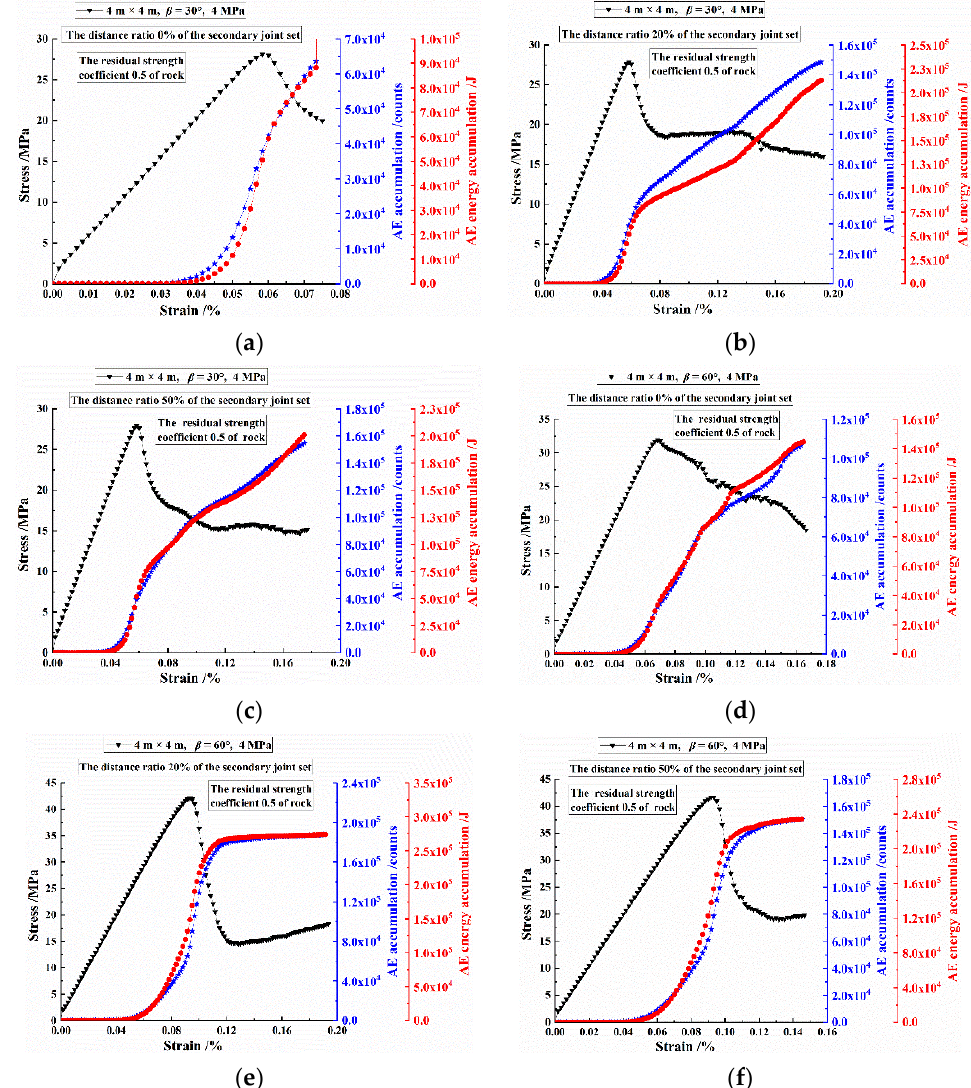
Figure 16. The AE counts and energy accumulations of the CJBs with different joint distance ratios: ( a – c ) for β = 30° and the joint distance ratios 0%, 20% and 50%, respectively; ( d – f ) for β = 60° and the joint distance ratios 0%, 20% and 50%, respectively.